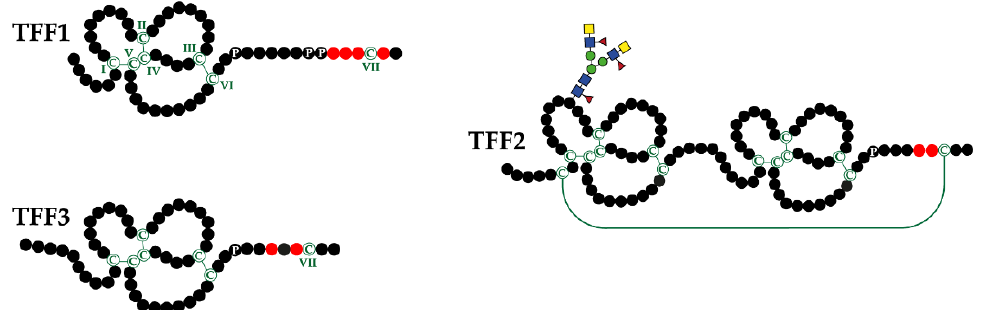
Figure 1. Schematic structures of the three human TFF peptides. Cysteine residues (C; numbering in Roman numerals) and disulfide bridges are shown in green. TFF2 contains an additional disulfide bridge between Cys-6 and Cys-104 creating a circular structure; also represented are the proline residues (P) at the C-terminal outside the TFF domains. Acid residues in proximity to the C-terminal cysteine residues that modify its reactivity (change of pKa) are shown in red.